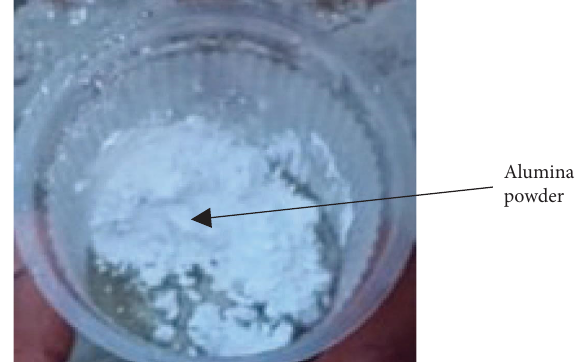
Figure 2: Alumina powder.